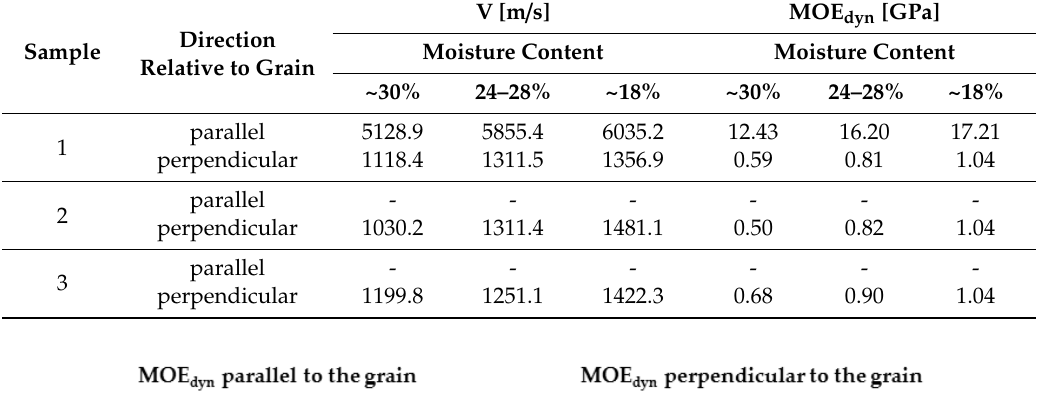
Table 9. Sylvatest Trio test results: velocity of ultrasonic wave propagation and dynamic modulus of elasticity depending on moisture content and direction relative to grain.